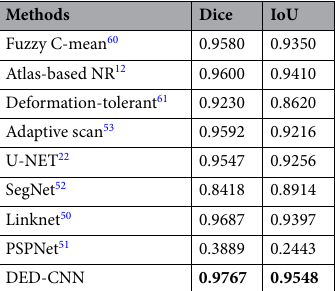
Table 3. Analysis of the lung segmentation results in the terms of the dice score and the IoU score using the MCCXR dataset. The bolded values demonstrate that the proposed approach performed better in terms of the metric presented in each column.